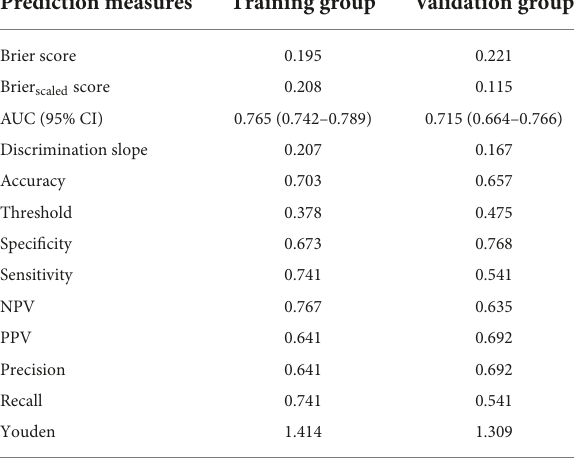
TABLE 3 Predictive effectiveness of the model to predict risk probability of poor sleep quality among university